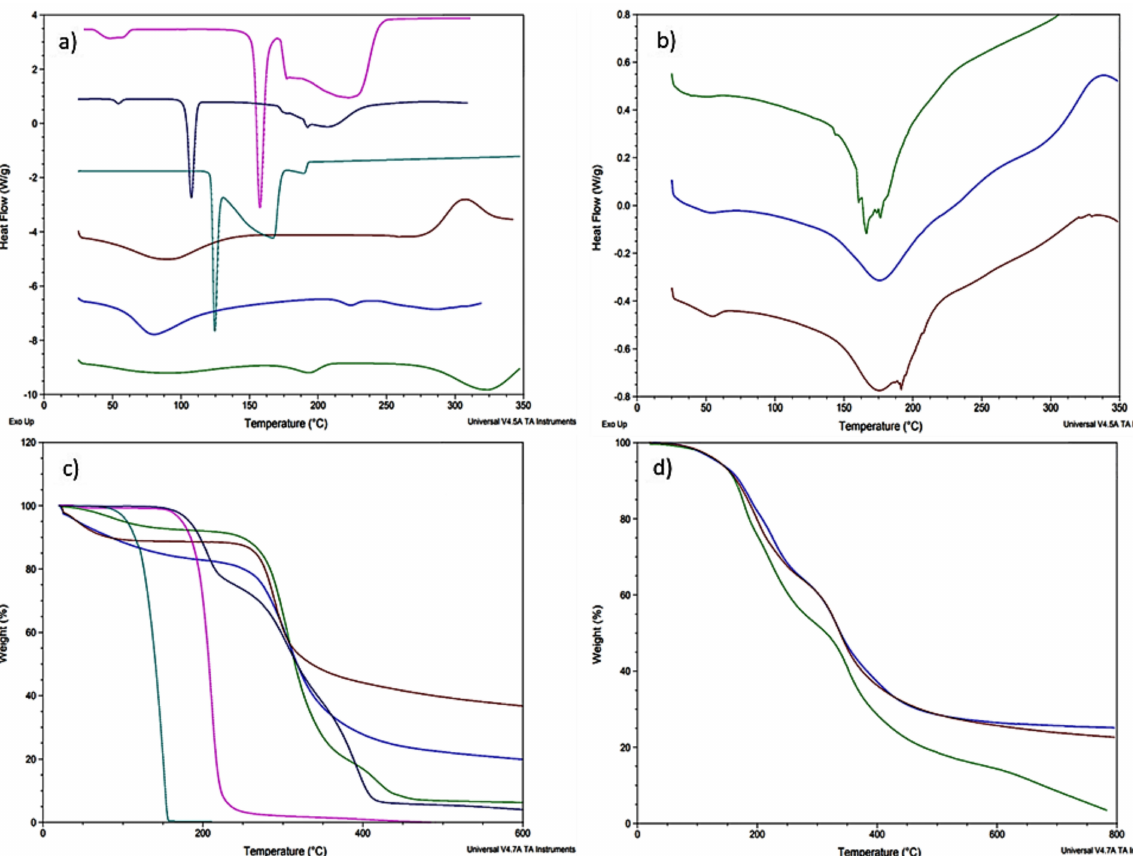
Figure 2. Thermal analysis; ( a ) DSC analysis of raw materials: chitosan (wine), PVA (green), gelatin (blue), DKT (dark blue), citric acid (fuchsia), and benzoic acid (aqua); ( b ) DSC analysis of the formulation prototypes: F1 (green), F2 (blue), and F3 (wine); ( c ) TG analysis of raw materials: chitosan (wine), PVA (green), gelatin (blue), DKT (dark blue), citric acid (fuchsia), and benzoic acid (aqua); ( d ) TG analysis of the formulation prototypes: F1 (green), F2 (blue), and F3